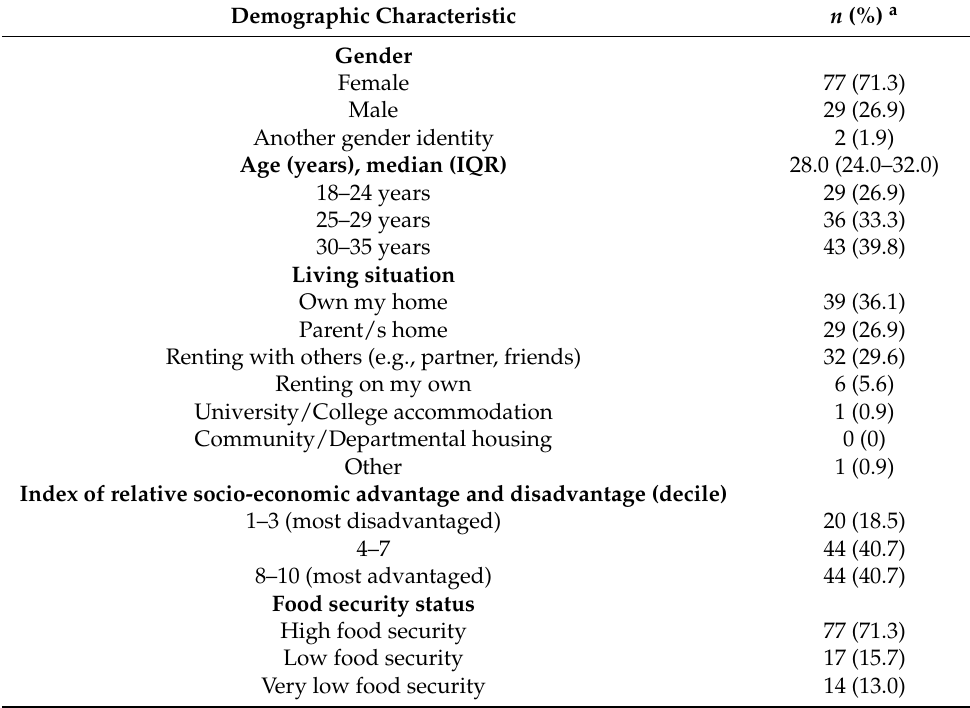
Table 1. Demographics of young adults with low diet quality who use the ‘No Money No Time’ website ( n =